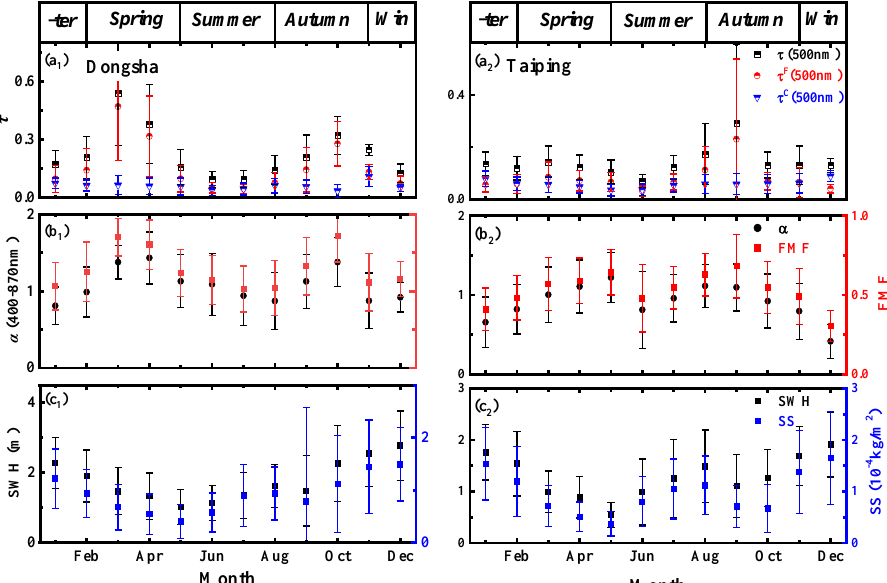
Figure 10. Monthly mean values of ( a 1 , a 2 ) τ (500 nm), τ F (500 nm), τ C (500 nm), ( b 1 , b 2 ) α (440– 870 nm), ( c 1 , c 2 ) the significant height of combined wind waves and swell (SWH) and sea salt aerosol mass concentration FMF in Dongsha and Taiping from January 2018 to December 2020. The error bars are standard deviations.